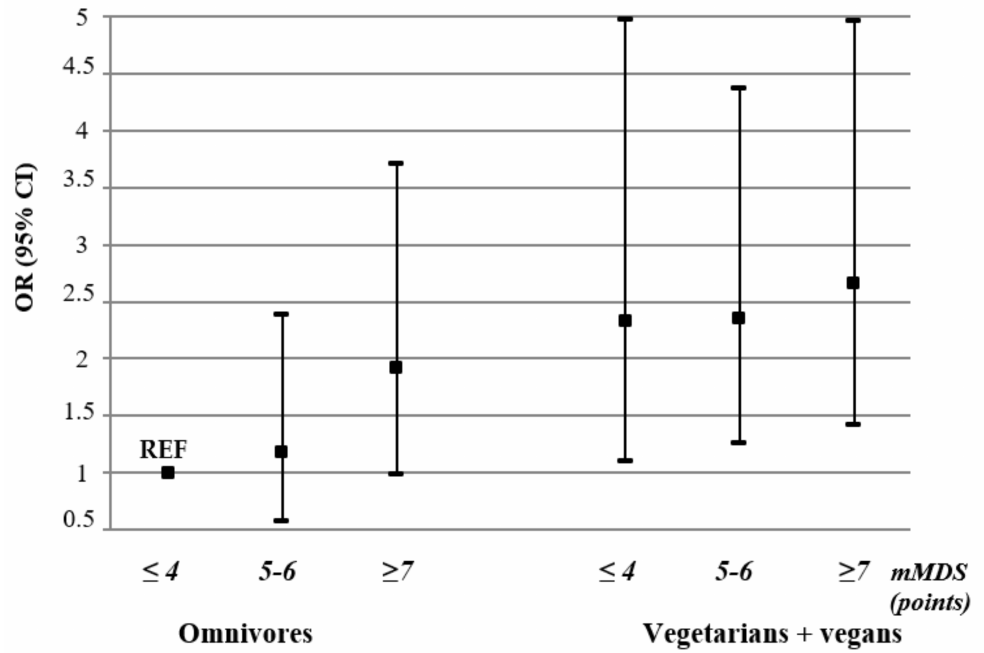
Figure 5. The likelihood of good well-being by the type of diet followed in women and adherence to modified Mediterranean Diet Score (mMDS). The presented results were adjusted for age, place of living, education, marital status, physical activity, BMI, health status, cigarette smoking, sleeping time, traumatic event, and stress level. Abbreviations: OR—odds ratio; CI—confidence interval; REF—reference